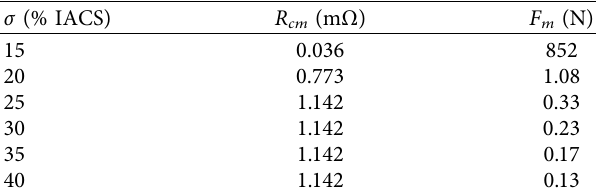
Figure 10: The relationship between R cm and σ . Table 2: Discrete results of F m under different values of σ .